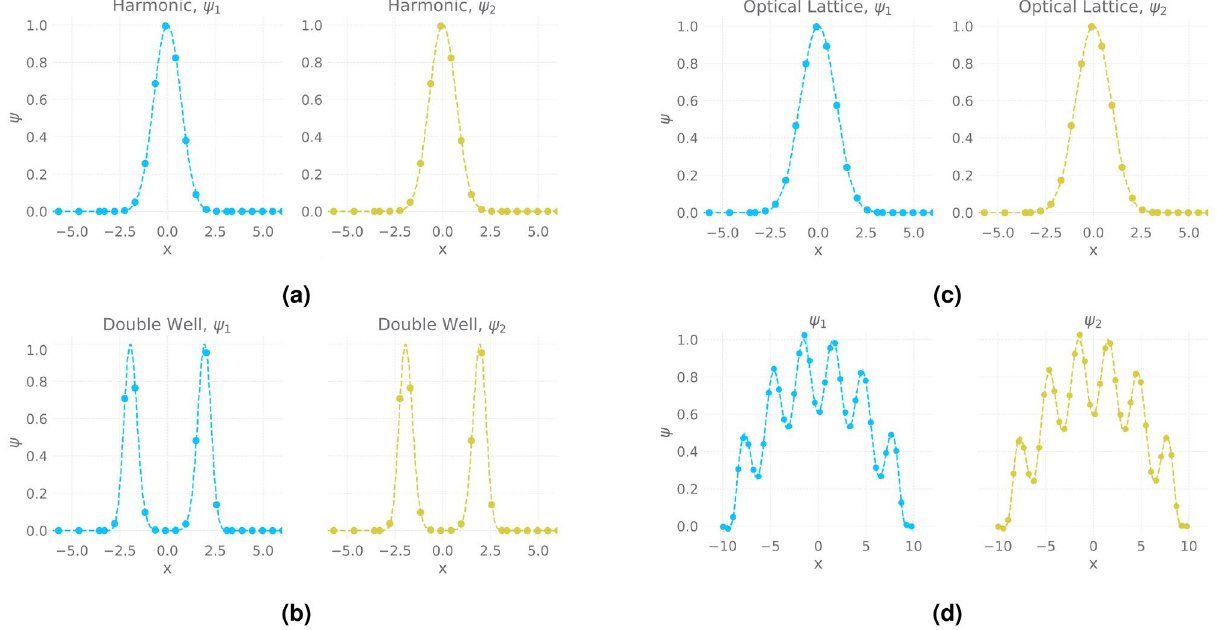
Figure 4. ( a,b,c ) Prediction of two-component BECs ground-state wave functions for different trapping potentials ( a ) Harmonic, ( b ) Double Well, ( c ) Optical Lattice ( d ) Emulation of Rabi-coupled two-component BECs conditioned on cosine potential.